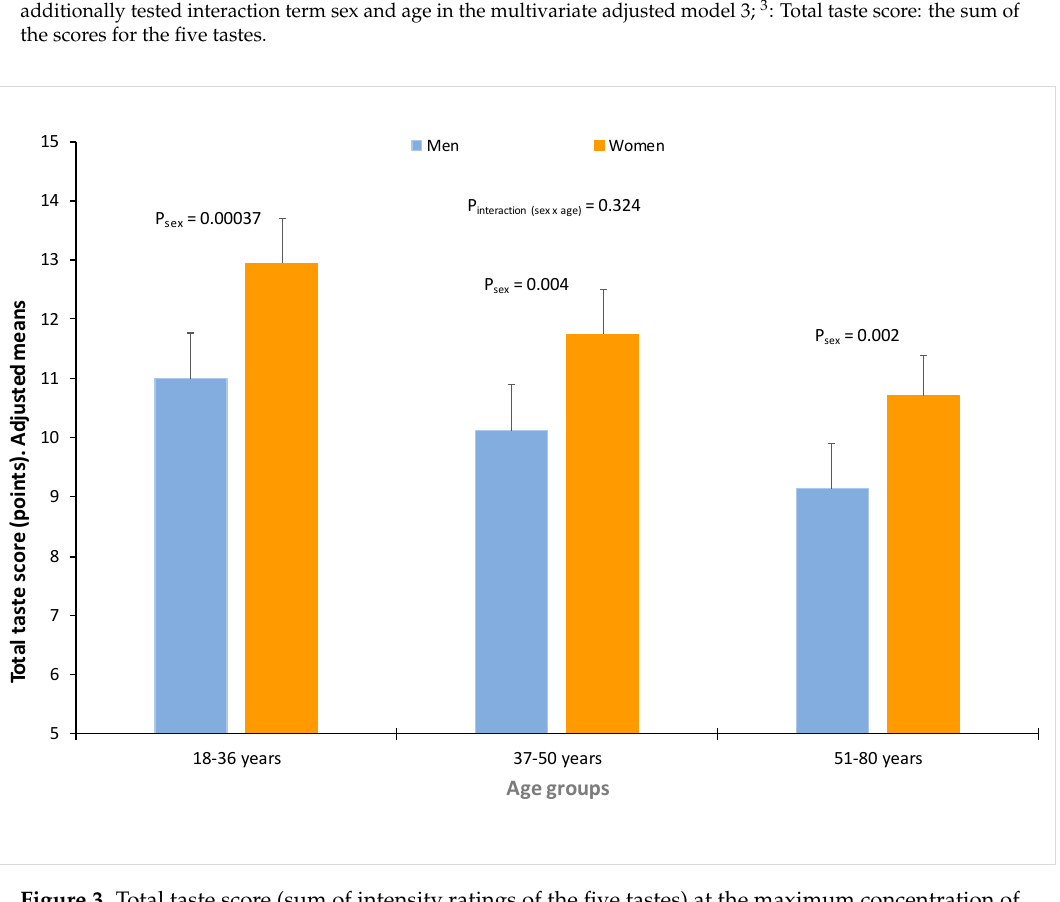
Figure 3. Total taste score (sum of intensity ratings of the five tastes) at the maximum concentration of the tastants tested (concentration V) by age group (18–36 years ( n = 342), 37–50 years ( n = 329) and 51–80 years ( n = 349)) in men ( n = 365) and women ( n = 655). Values are adjusted means (model 3) including sex, age, diabetes, body mass index, smoking and medications. p -values show the statistical significance of the differences in total taste perception by sex in each age group, after adjustment for covariates (model 3). Error bars are SE.